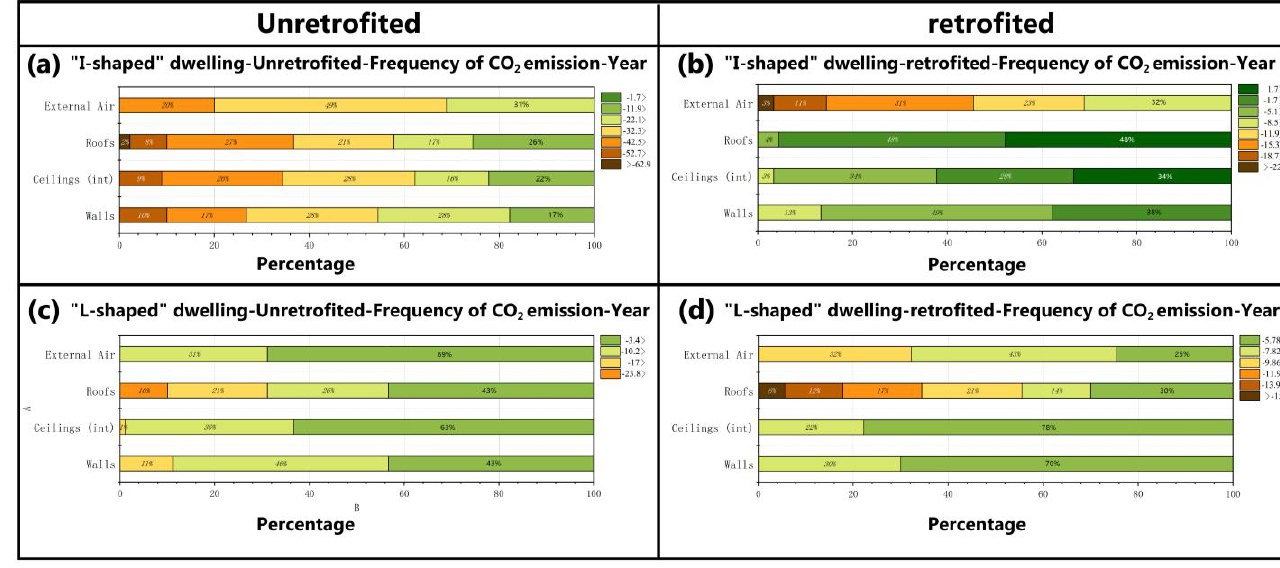
Figure 14. Frequency of CO 2 emission. ( a ) CO 2 emission frequency of “I - shaped” dwelling before the retrofitting; ( b ) CO 2 emission frequency of “I - shaped” dwelling after the retrofitting; ( c ) CO 2 emission frequency of “L - shaped” dwelling before the retrofitting; ( d ) CO 2 emission frequency of “L -shaped ” dwelling after the retrofitting.